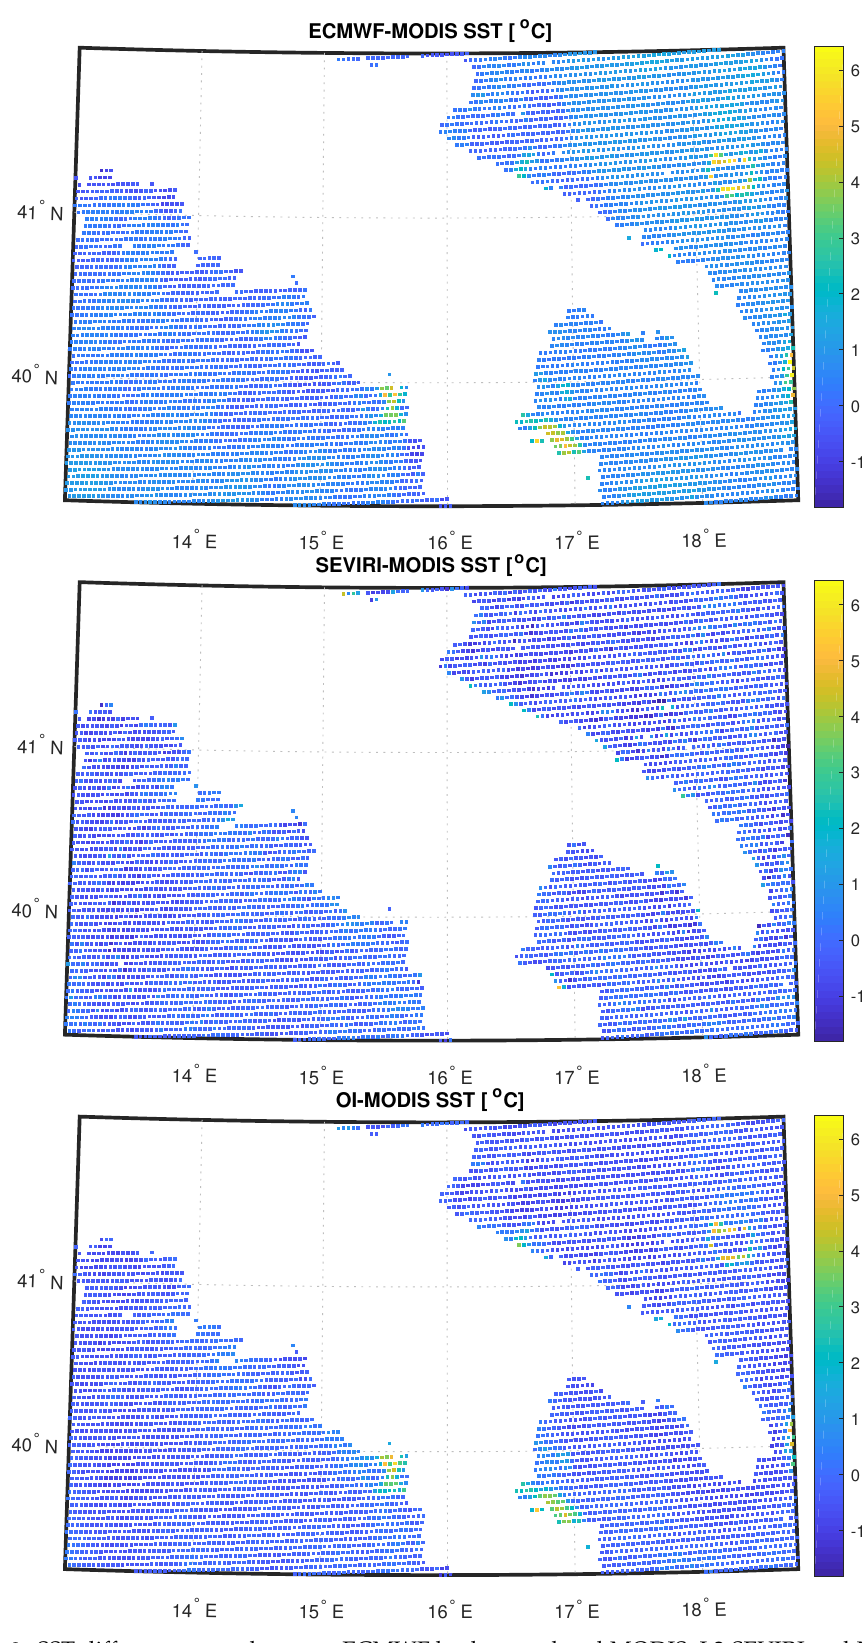
Figure 9. SST difference maps between ECMWF background and MODIS, L2 SEVIRI and MODIS, OI and MODIS for the 11 August